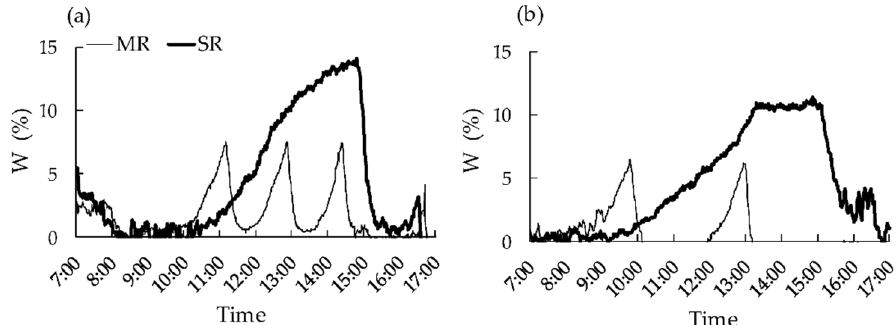
Figure 3. Typical diurnal changes in the wilting ratio (W) in MR and SR from 07:00 to 17:00 on a sunny day ( a ) and a cloudy day ( b ). MR: moderate wilting–full recovery treatment; SR: severe wilting–full recovery treatment.